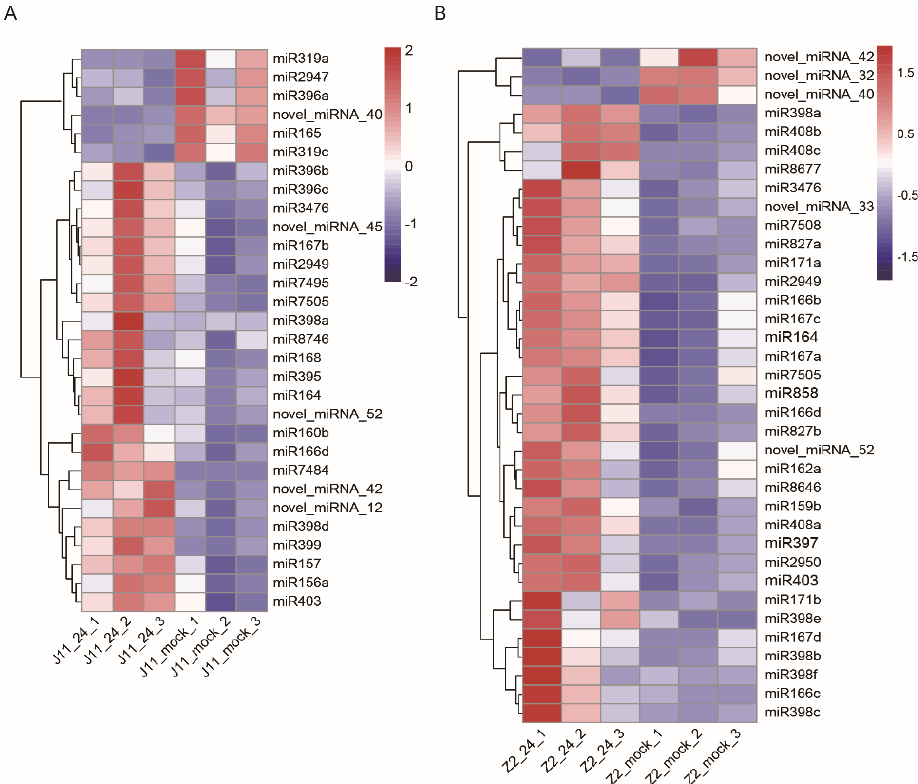
Figure 4. Expression profiling of miRNAs in response to V. dahliae stress in J11 ( A ) and Z2 ( B ). Hierarchical clustering of differentially expressed miRNAs in J11 ( A ) and Z2 ( B ). Red and blue colors show upregulation and downregulation, respectively. The original expression values of the miRNAs were normalized using Z-score. The signal intensity ranges from − 2 to 2 and − 1.5–1.5 as the corresponding color also changes from blue to